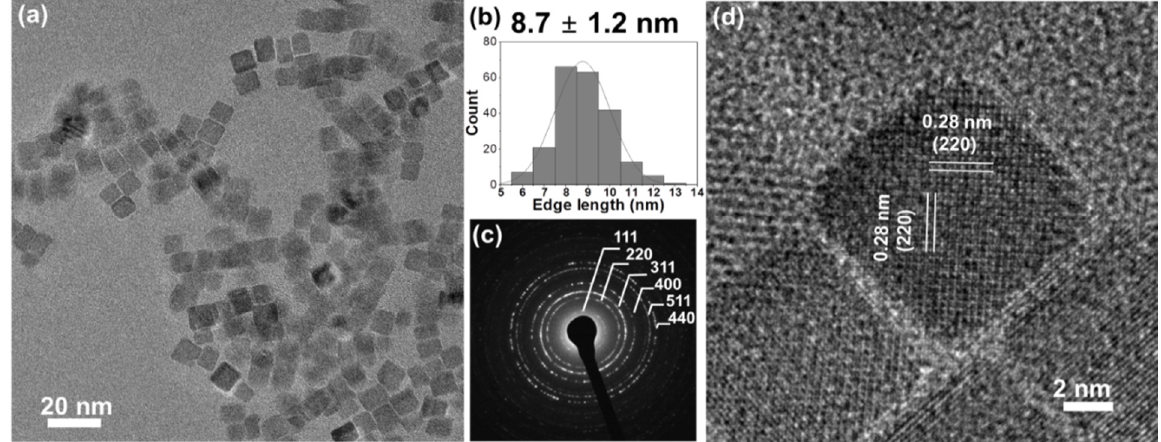
Figure 1. ( a ) Overview TEM and ( d ) high resolution TEM images; ( b ) edge-length histogram (including the mean value of edge length ± standard deviation) and ( c ) SAED pattern of Co 3 O 4 cubes.